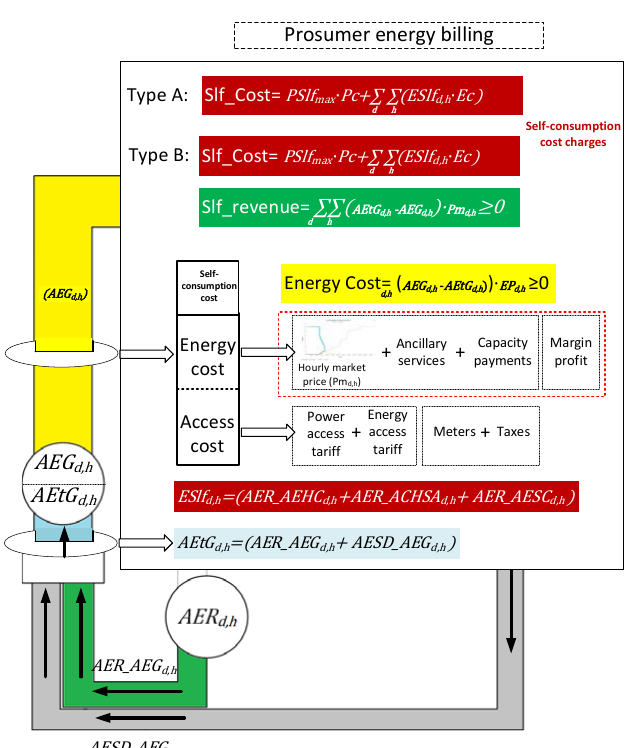
Figure 7. Representation of the prosumer’s billing subjected to the self-consumption structure. Source: self-elaboration.